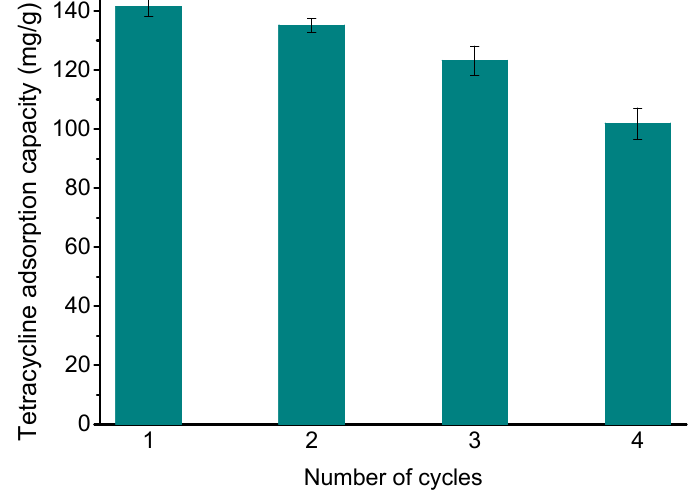
Figure 8. Reusability of the Fe 3 O 4 @GO for TC removal.